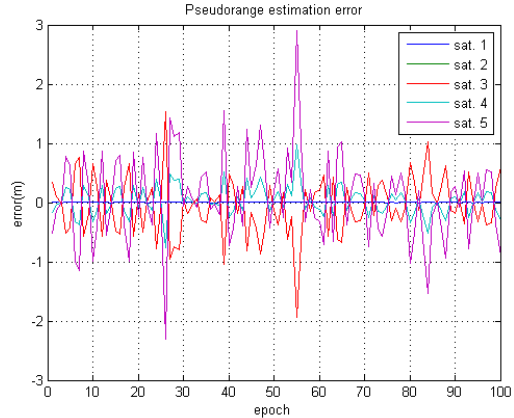
Figure 13. Estimated Pseudorange